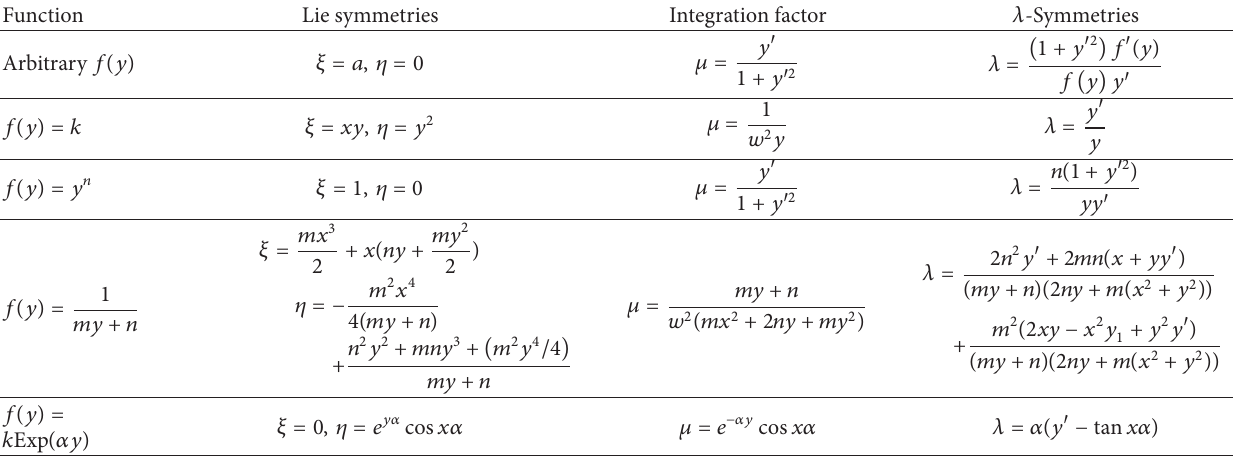
Table 2: Table of 𝜆 -symmetry classification with Lie symmetry of path equation. Function Lie symmetries Integration